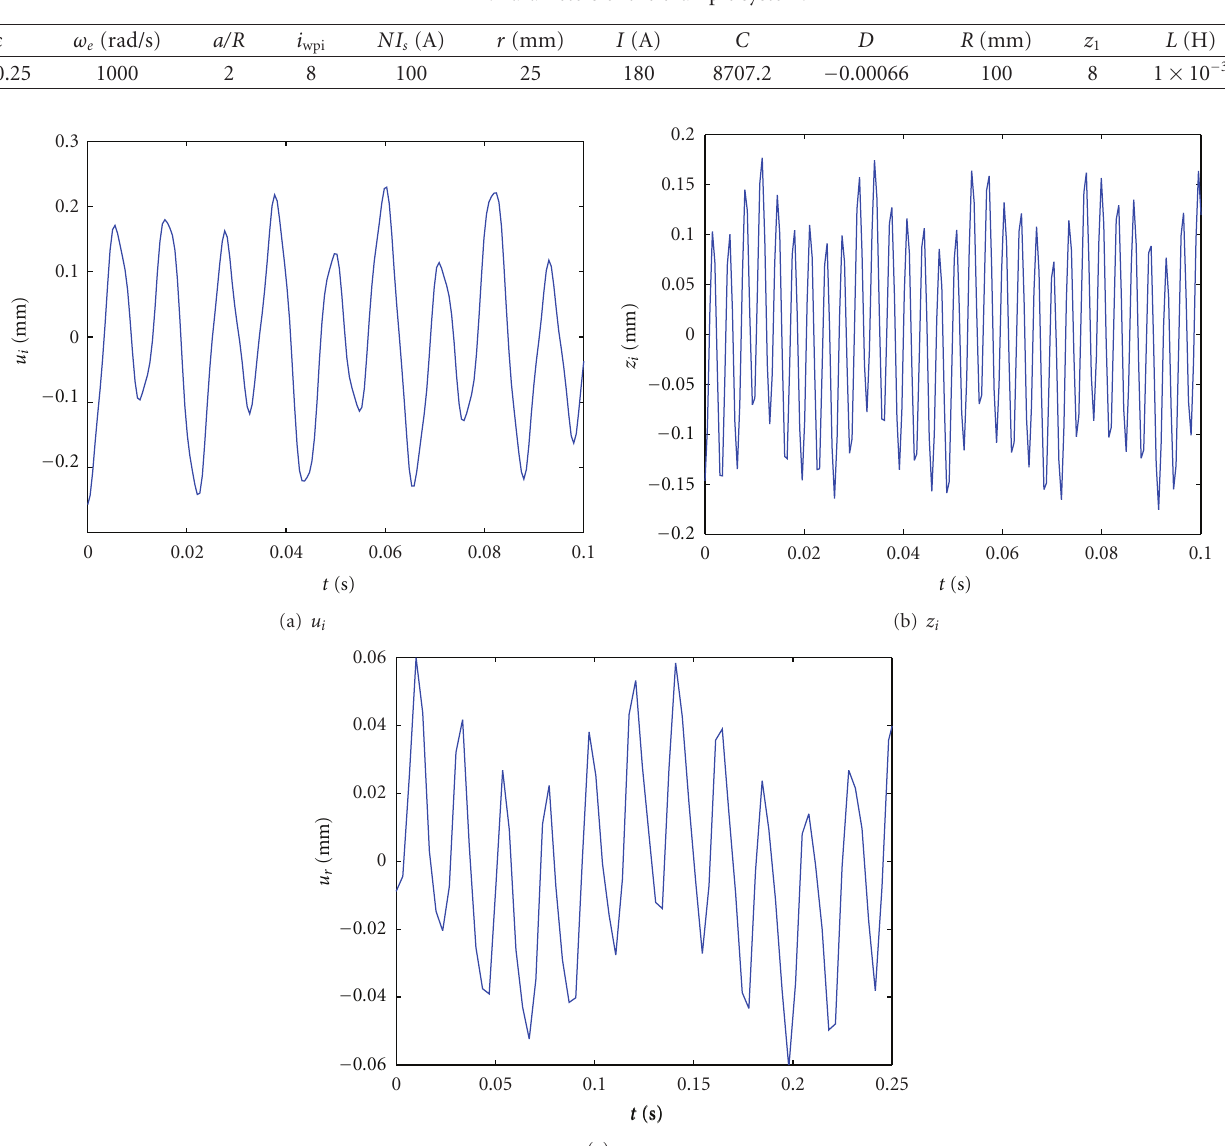
Table 1: Parameters of the example system.